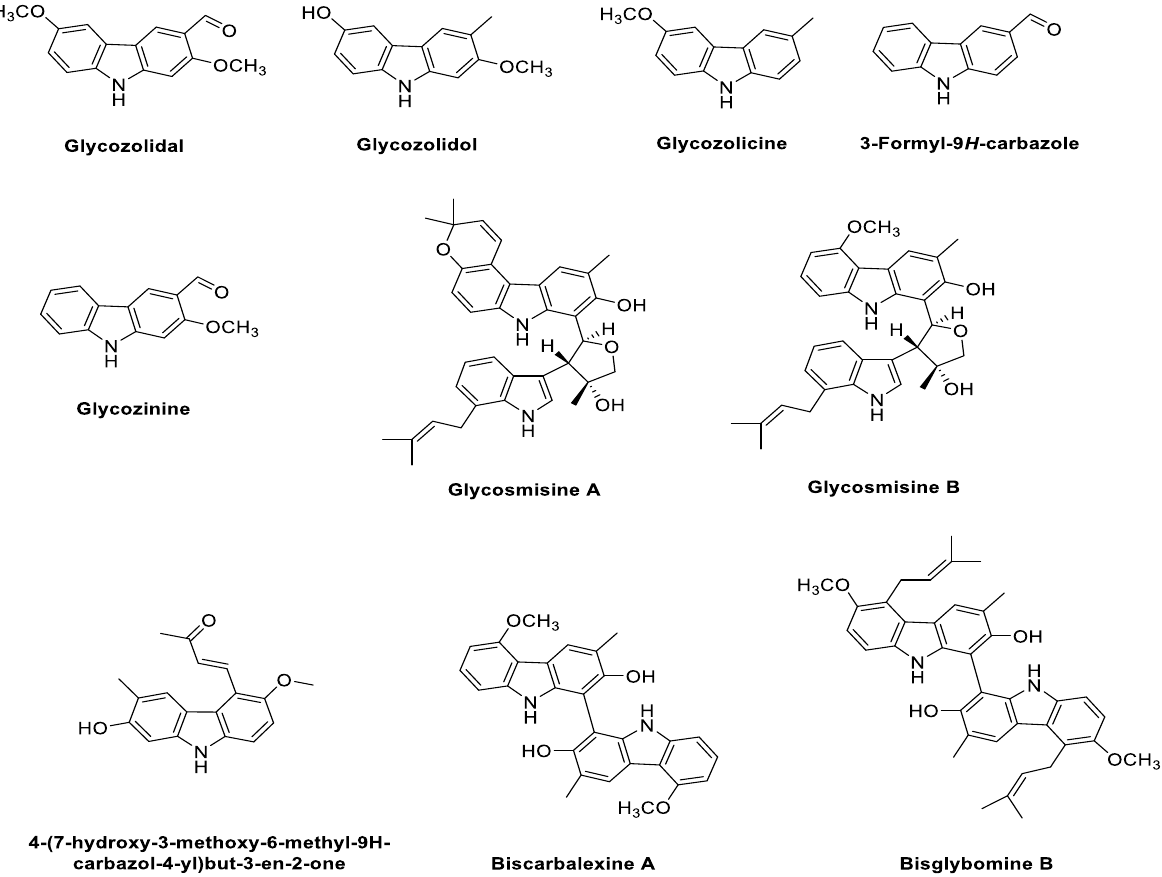
Figure 4. Potential phyto-carbazole alkaloids from Glycomis pentaphylla .